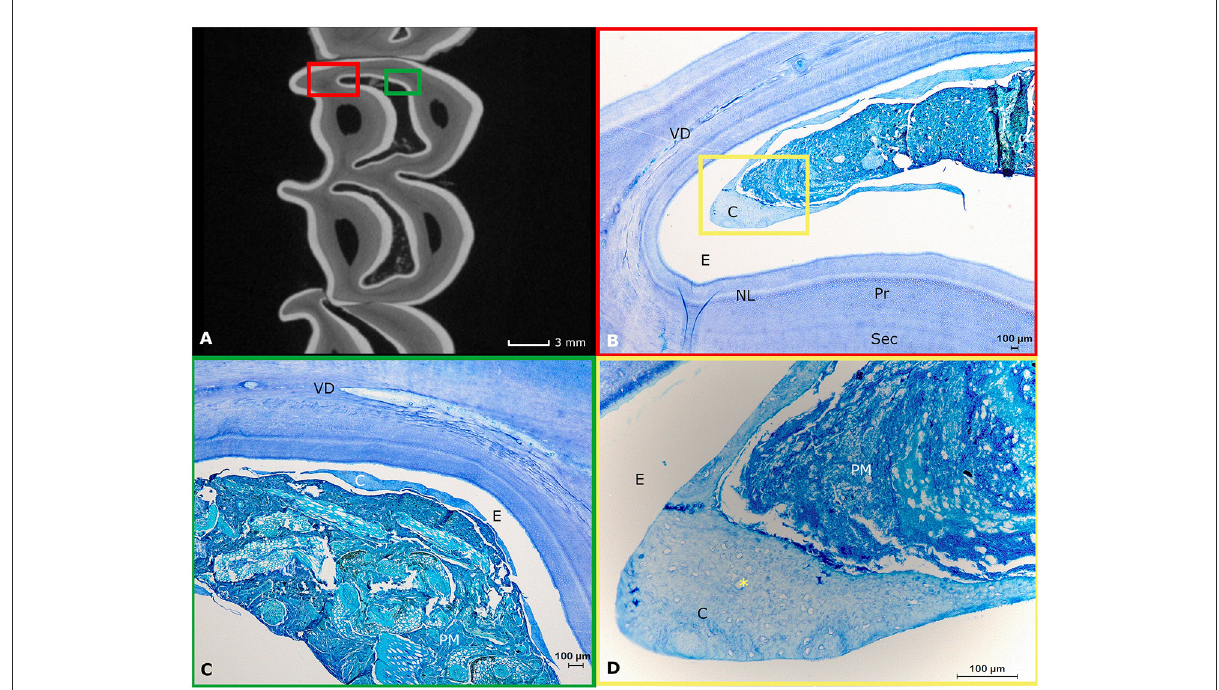
FIGURE5 Histological appearance of infundibular structures. (A) A two-dimensional transverse µ -CT image of the subocclusal region (3mm subocclusally) of a first molar in the left upper jaw originating from a 3-years-old alpaca shows the normal appearance of the infundibulae in alpaca cheek teeth (two centrally located white enamel rings; Dental age 2 years and 4 months). (B) Detail of the mesio-palatal edge of the mesial infundibulum (Histological presentation of content in red box Figure 4A). Infundibula in this species consist of wide enamel cusps largely filled with food, primarily consisting of plant material and little amounts of low cellular cementum (C). The narrow spaces created in-between the peripheral and infundibular enamel are prone to show the presence of vasodentin (VD). The normal structure of primary (Pr) and secondary dentin (Sec) is visible. A neonatal line (NL) is visible as a white line in this first maxillary molar. In the white space, enamel (E) used to be present prior to decalcification. (C) Histological representation of content indicated in the green box in (A) . In the center of this mesial infundibulum, even less cementum (C) can be perceived. The plant material (PM) is primarily occupying the former enamel cusp. Again, the white zone indicated by E was filled with enamel prior to any decalcification processes. Vasodentin is clearly represented in this specific histological section (VD). (D) Magnification of the zone indicated by a yellow box in (B) . A large amount of plant material (PM) and cementum (C). Detail of the infundibular cementum showing multiple cemental lacunae ( * ). The white zone indicated with an E was formerly filled with infundibular enamel prior to any decalcification processes.